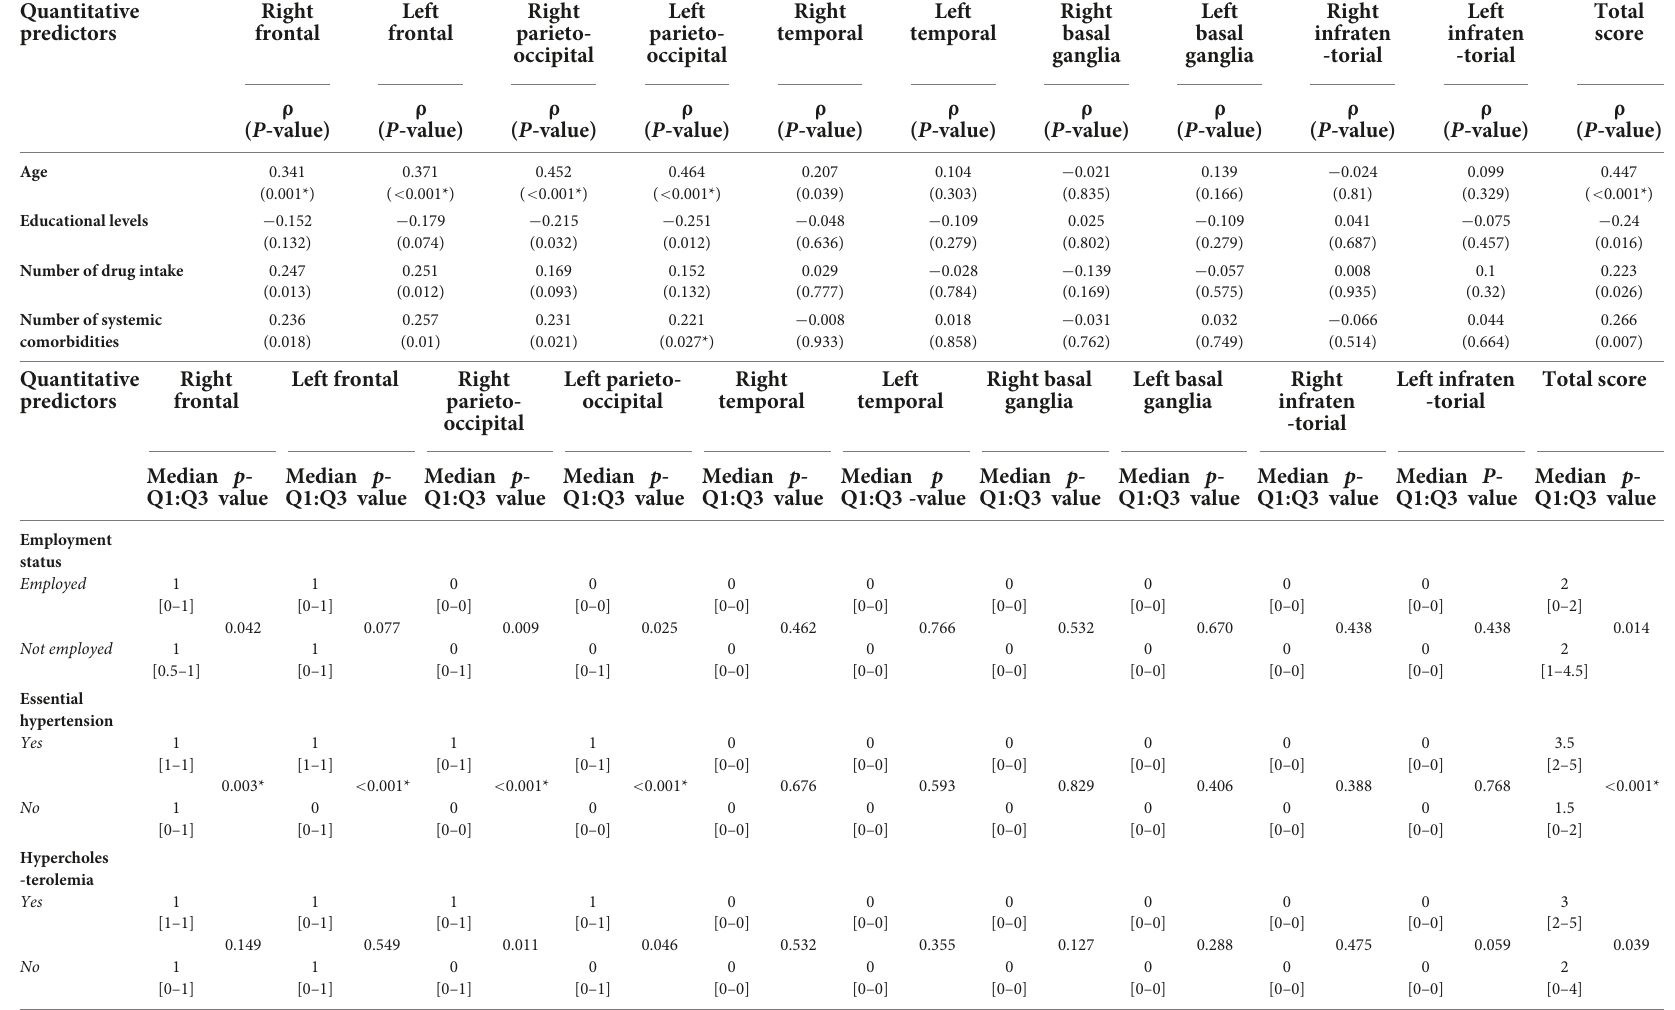
TABLE 6 Linear correlation analysis between the ARWMC sub-scores and statistically significant quantitative/qualitative predictors of the total ARWMC score in the BMS patients. Quantitative